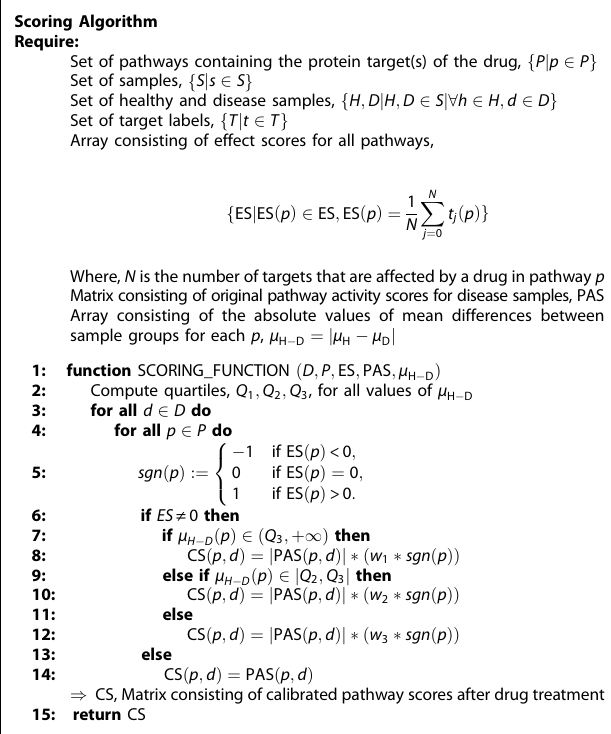
Box 1 Scoring algorithm pseudocode . The pseudocode outlines the scoring algorithm used to modify the pathway activity scores of a given